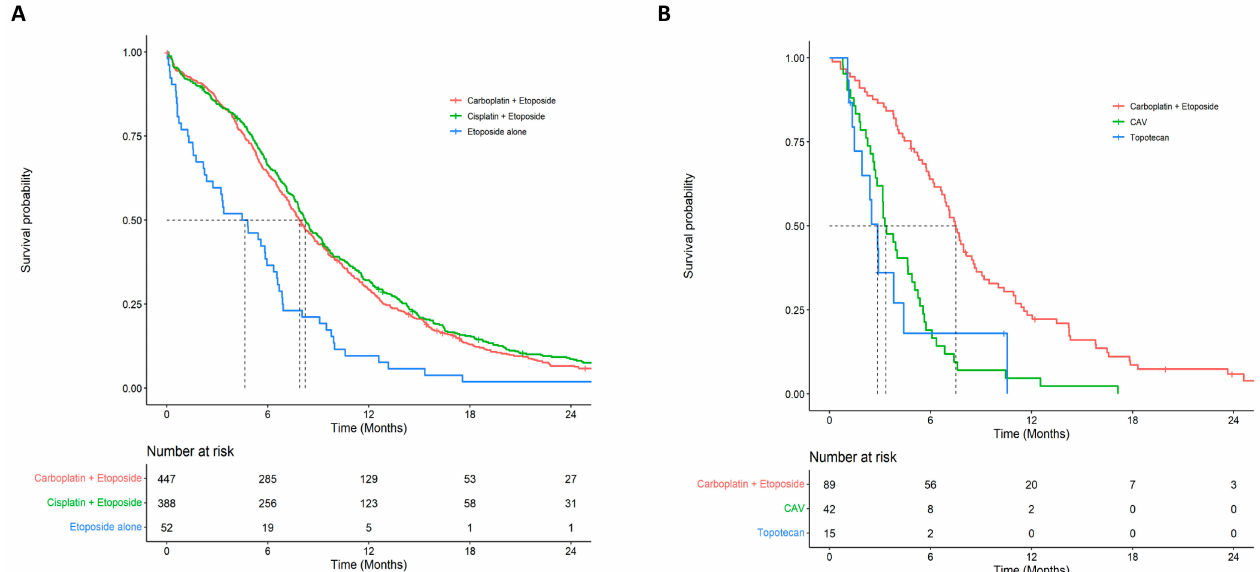
Figure 2. Overall survival by treatment for first- and second-line chemotherapy: ( A ) first-line overall survival by type of chemotherapy regimen; ( B ) second-line overall survival by type of chemotherapy